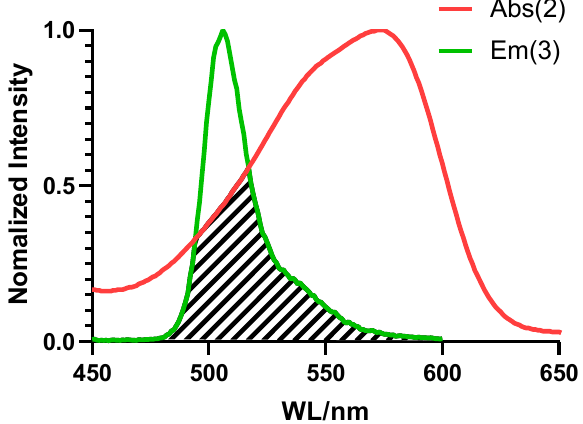
Figure 1. Necessary conditions for FRET to occur: The normalized fluorescence spectrum of the donor part (BODIPY, compound 3 , shown as the green curve) overlaps the normalized absorption spectrum of the acceptor part (benzopyrylium, compound 2 , shown as the red curve).